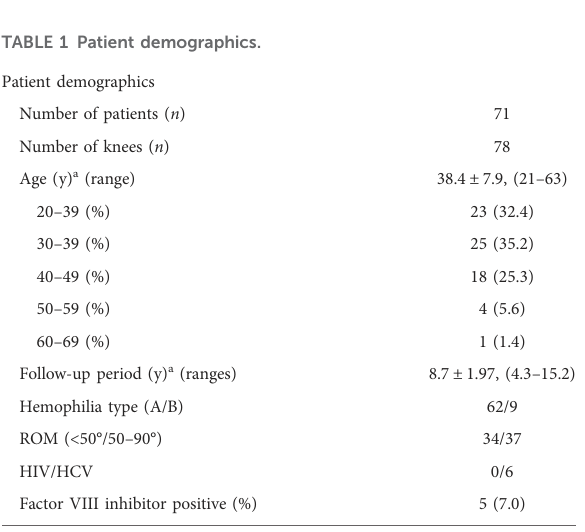
TABLE 1 Patient